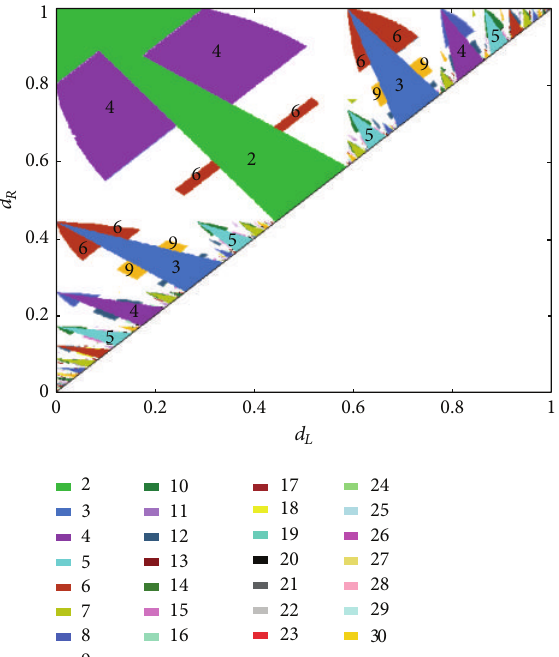
Figure 5: 2D bifurcation diagram of 𝑓 in the (𝑑 𝐿 , 𝑑 𝑅 ) -parameter plane for 𝑎 𝐿 = 0.7 , 𝑎 𝑅 = 0.8